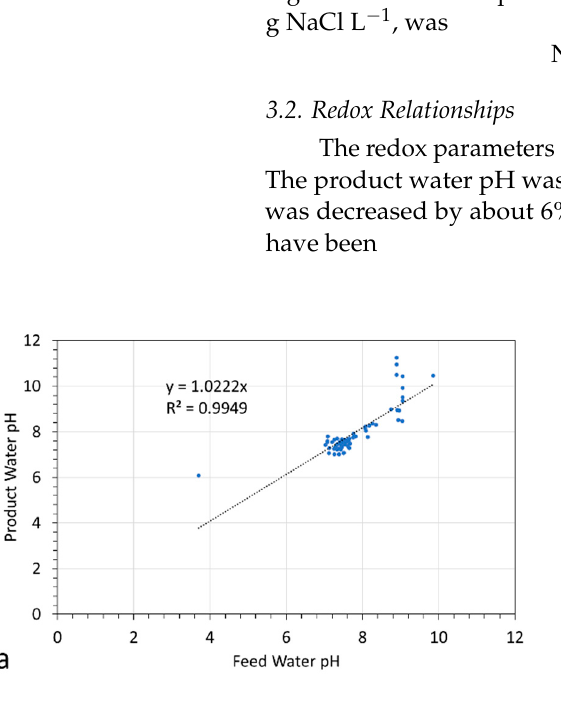
Figure 7. Redox parameters. ( a ) pH; ( b ) Eh.